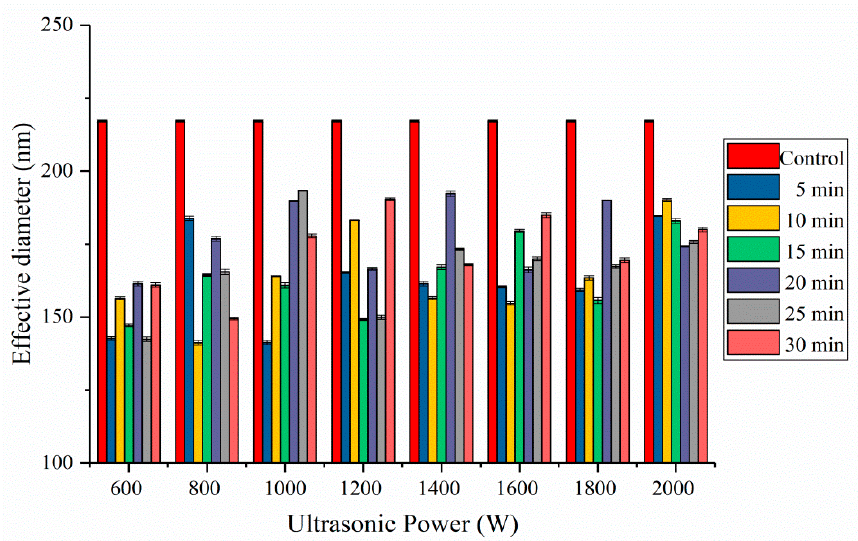
Figure 5. Effective diameter for SPI samples filtered at 0.45 μ m. Data are the averages of three replications ± standard deviation.